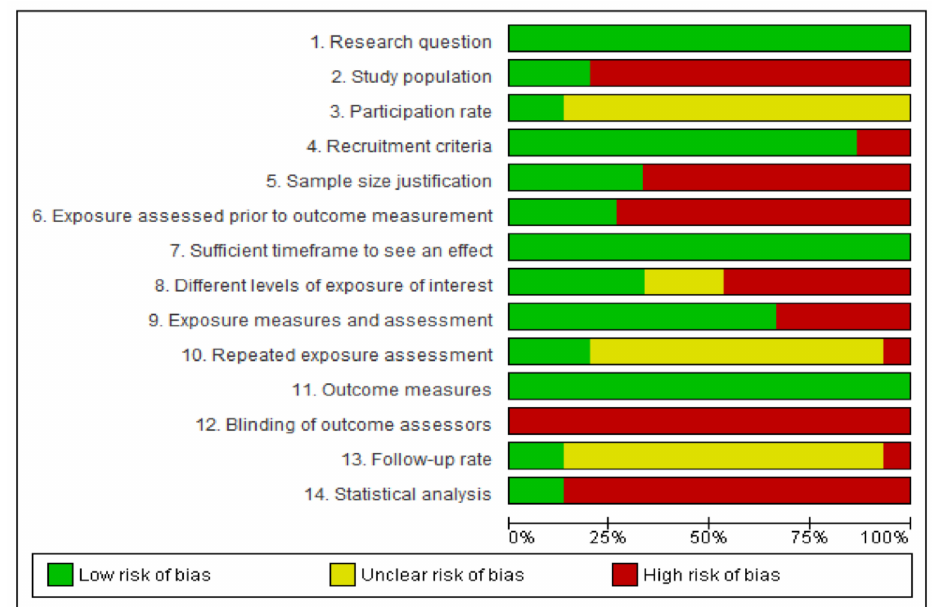
Figure 2. Risk of bias: judgements about each risk of bias item presented as percentages across all included